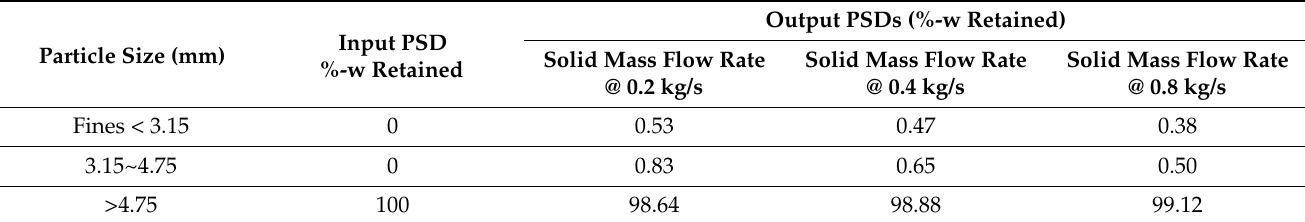
Table 6. Degradation of fresh pellets at an air flow rate of 0.30 kg/s with bends in